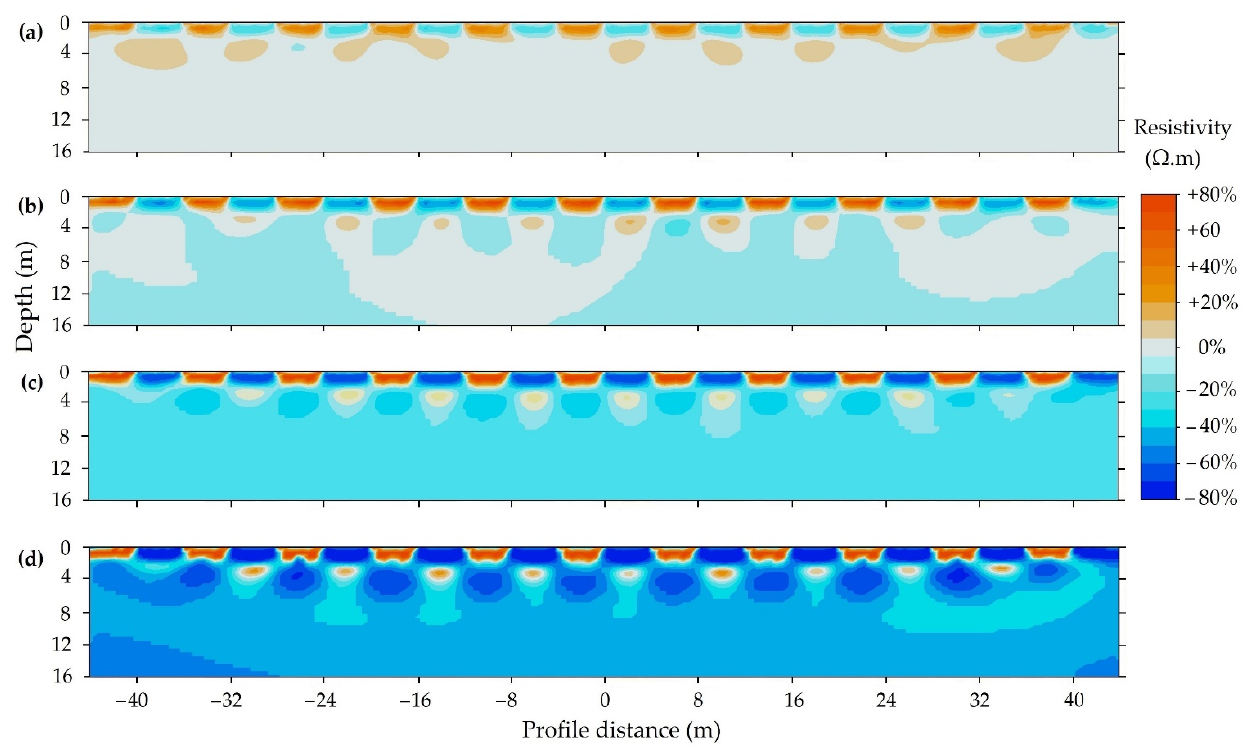
Figure 27. Pole-dipole (PD) array sensitivity to resistivity perturbations. The inverted model for: ( a ) ±20% perturbation,